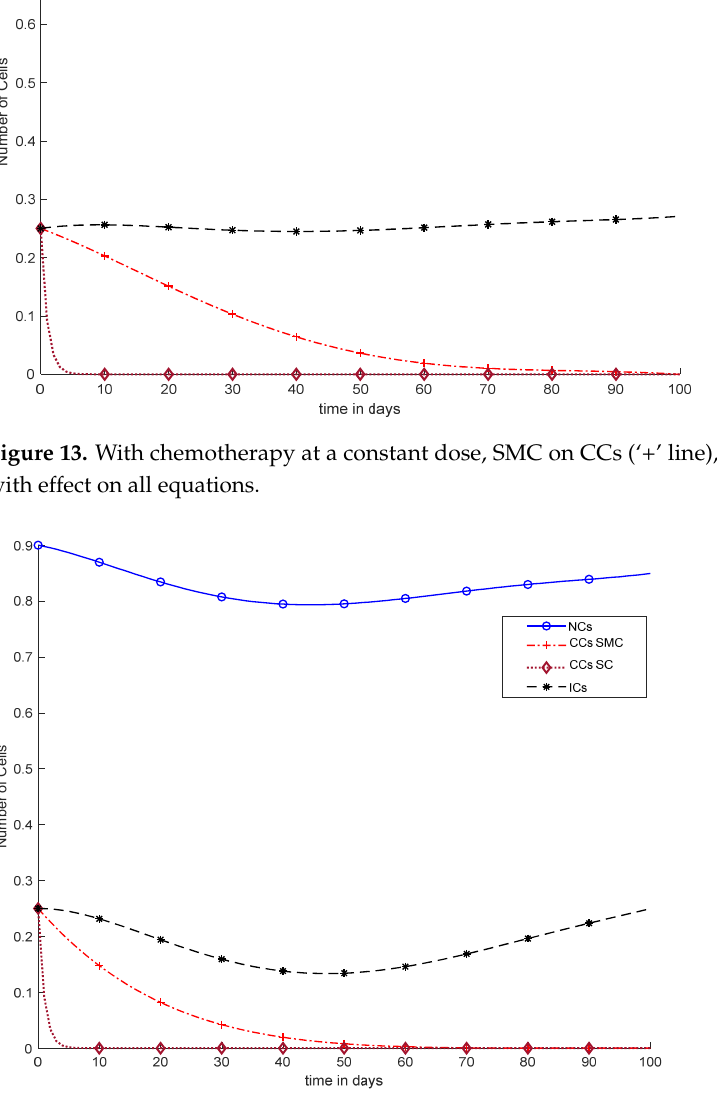
Figure 14. With chemotherapy at a continuous dose, SMC on CCs (‘+’ line), and SC to kill CCs (‘ − ’ line) with effect on all equations.